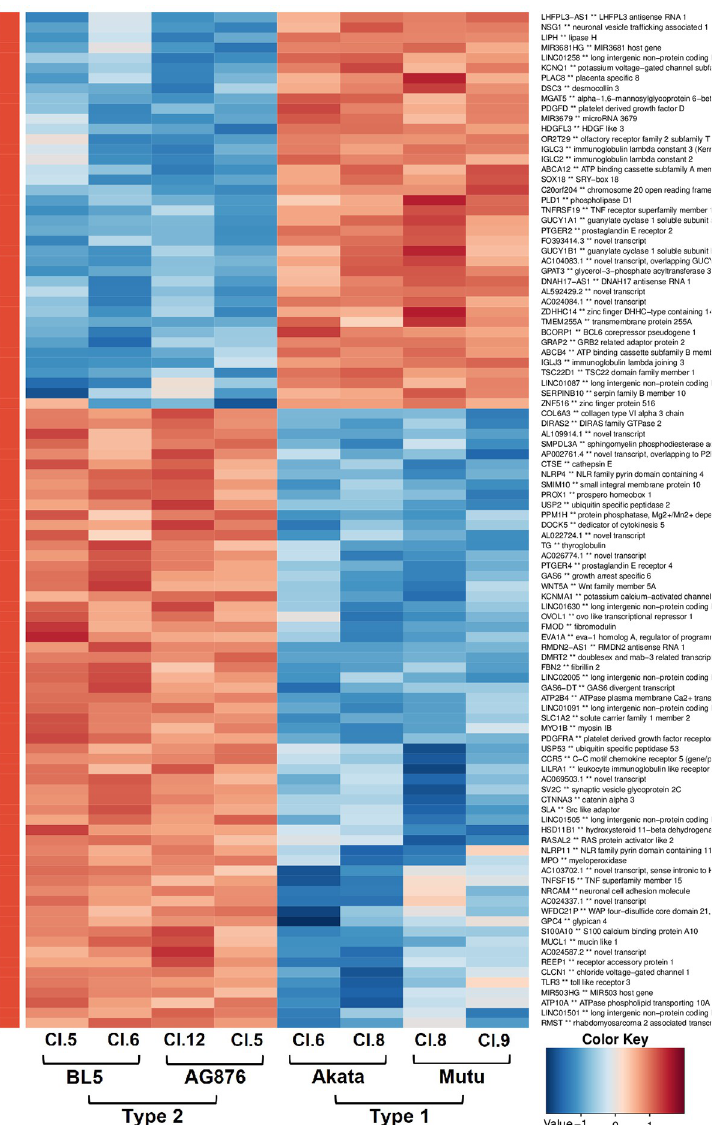
Fig 1. Comparison of cellular transcripts in Type 1 EBV versus Type 2 EBV infected lymphoblastoid cell lines. The top 100 differentially expressed cellular genes in the RNA-seq analysis are shown. Names for each cell line, as well as the EBV type and strain are shown. Red indicates a gene is upregulated in corresponding cells and blue indicates it is down-regulated. GSEA identified that five Hallmark gene sets (epithelial_mesenchymal transition, angiogene- sis, coagulation, oxidative phosphorylation and adipogenesis) were significantly enriched in the comparison of gene expression in T2 versus T1 LCLs ( Fig 3) . As shown in Fig 4A , one of the gene sets that was most highly upregulated in T2 LCLs was the “Pre_vs_Day 7_post_TIV_- Flu_Vaccine_Bcell_Up” gene set. This set identifies genes upregulated in the B cells of humans injected with influenza vaccine who developed a good antibody response [27], and suggests that T2 LCLs have a signature indicative of antigen-stimulated/BCR-activated B cells. Consis- tent with this interpretation, another gene set significantly upregulated in T2 EBV LCLs versus T1 LCLs was the “unstimulated versus IGM stimulated B cell 24 hour up” gene set [28].